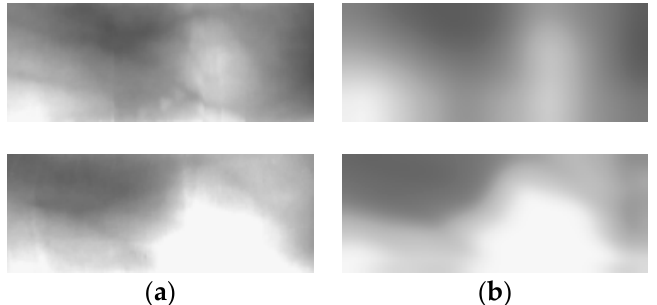
Figure 9. Examples of original and blurred images of PolyU-DB. ( a ) Original images, ( b ) motion and optical blurred images.